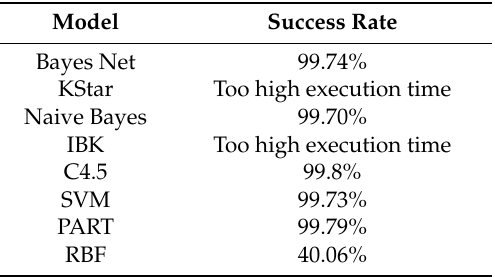
Table 3. Percentage of success obtained using different